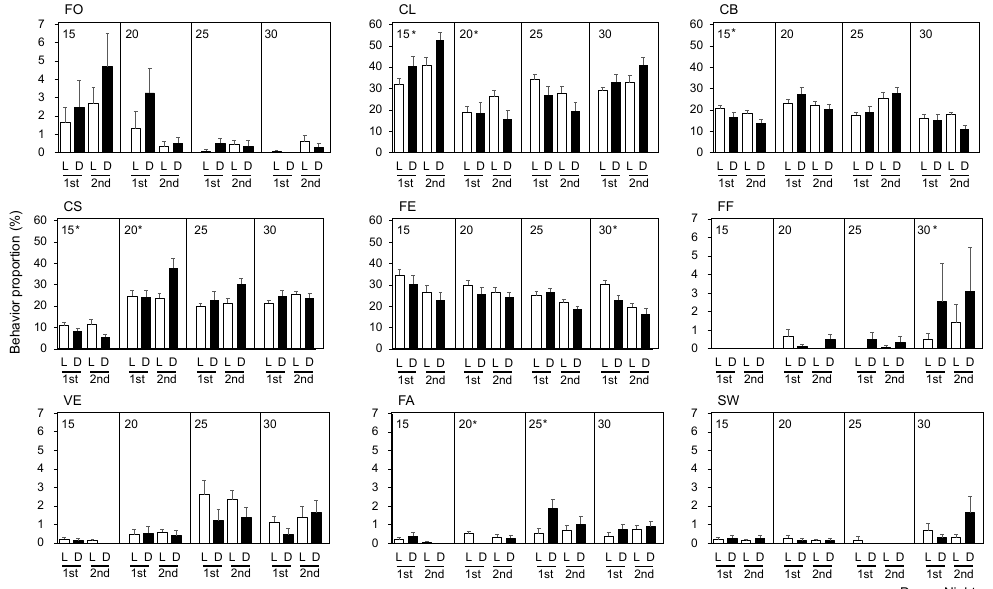
Figure 3. Comparison of the proportions of nine behavioral categories between day and night conditions in different water temperatures for two days. Error bars indicate standard error of each behavior. (L: Light, D: Dark, 1st: First day, 2nd: Second day). * indicates statistical difference between day and night based on Mann–Whitney U test ( p < 0.05).